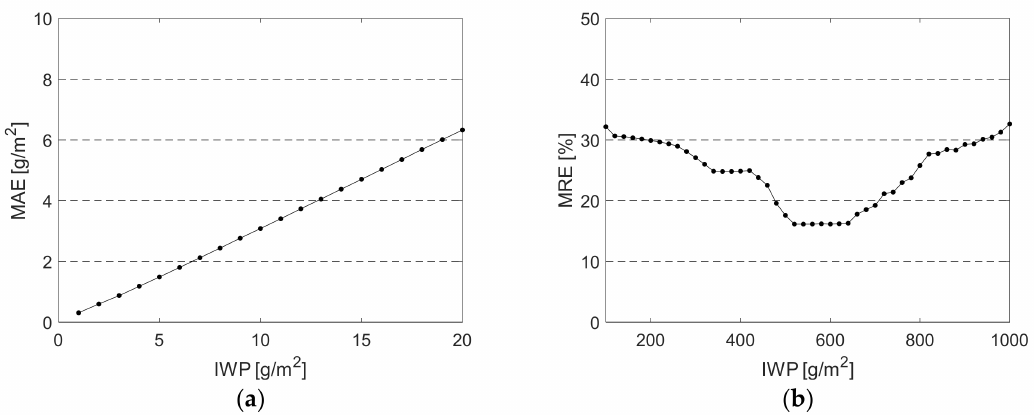
Figure 7. The inversion error of di ff erent ice water paths. ( a ) Median absolute error for low ice water path; ( b ) Median relative error for high ice water